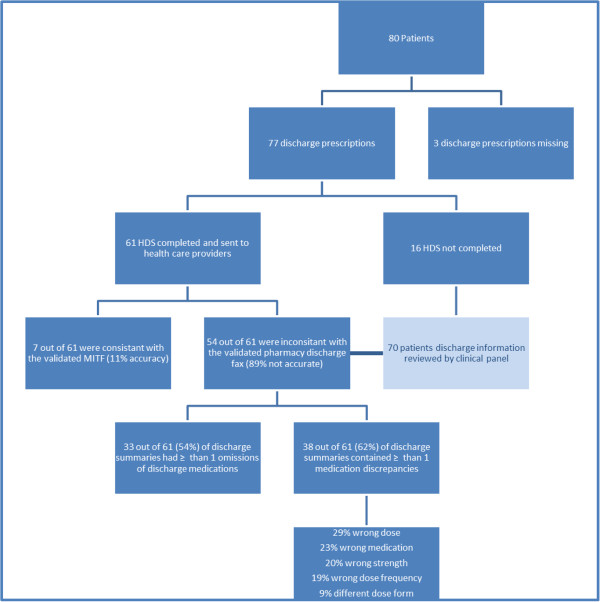
Audit flow chart.